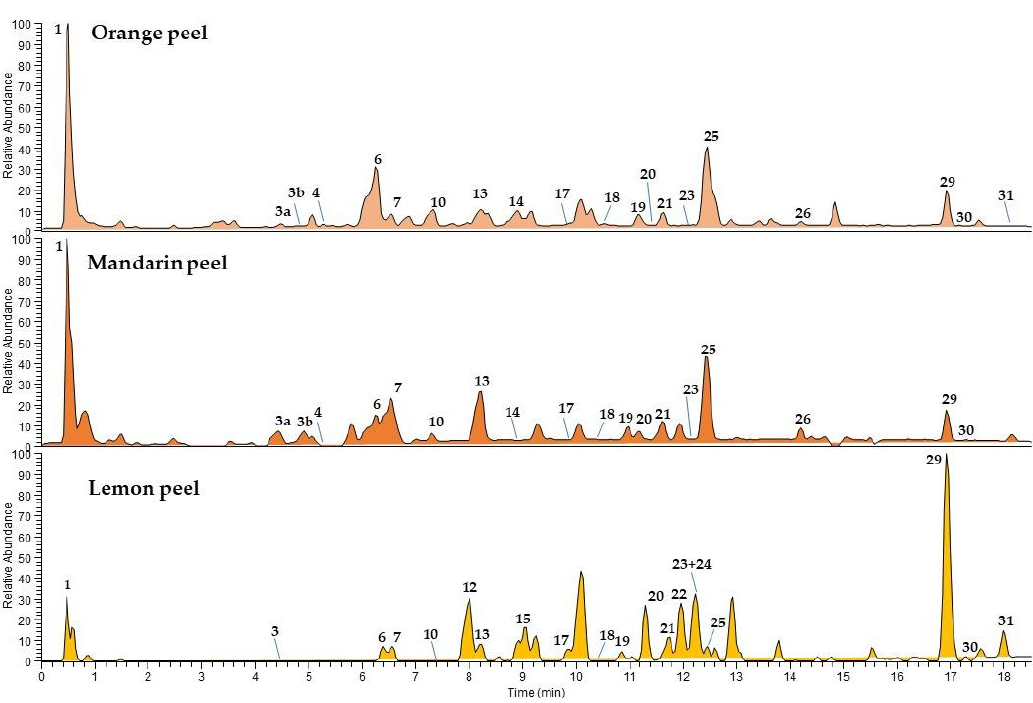
Figure 2. UHPLC-HR-ESI-MS/Orbitrap profiles, registered in negative ionization mode, of n -butanolic extracts of Citrus peels. Peak data are shown in Table 4.